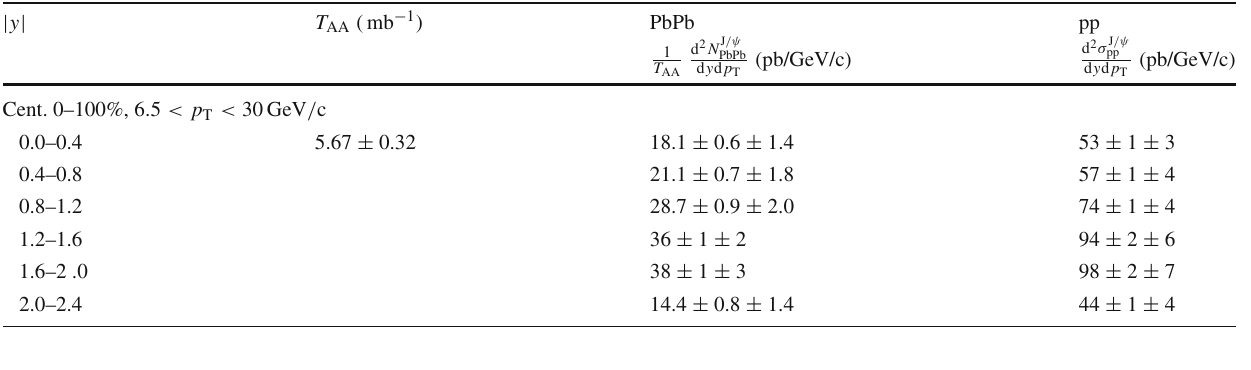
Table 3 The prompt J /ψ fiducial cross section in bins of p T , measured in PbPb and pp collisions at 2.76TeV within the muon acceptance defined by Eq. (4), and the nuclear overlap function ( T AA , with its systematic uncertainty). Listed uncertainties are statistical first and systematic second. A global systematic uncertainty of 6.5% (3.7%) affects all PbPb (pp) fiducial cross sections. The table corresponds to the bottom panel of Fig.